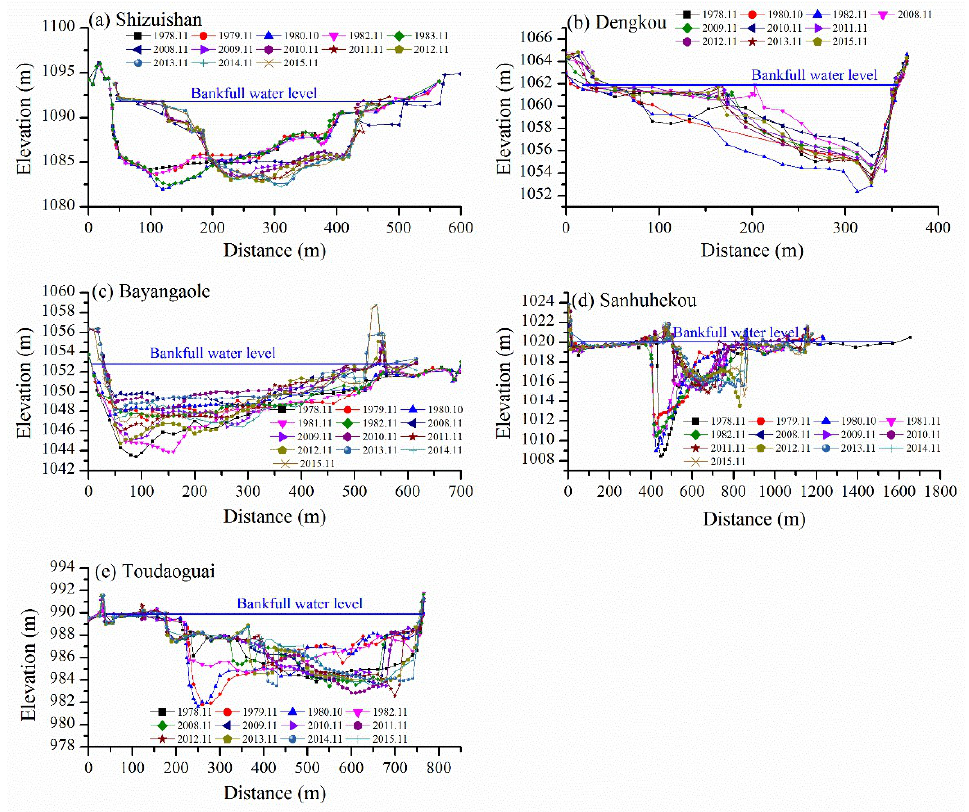
Figure 2. Typical cross-sections and the bankfull water levels at the five gauging stations: ( a ) Shizuishan station; ( b ) Dengkou station; ( c ) Bayangaole station; ( d ) Sanhuhekou station; and ( e ) Toudaoguai station.